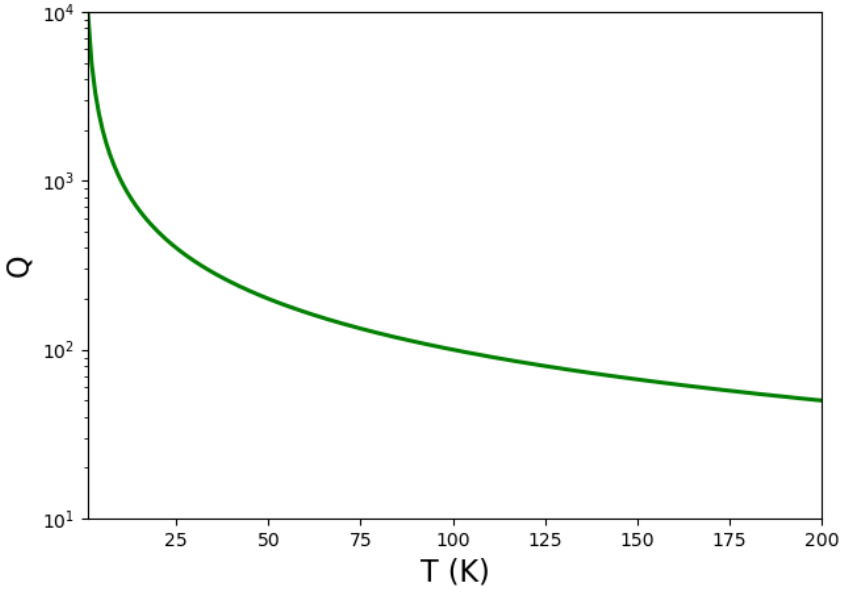
Figure 2: Dependence of the mechanical quality factor Q with temperature for Ω = 4GHz, κ = 1MHz and g = 10kHz, that exactly matches the standard